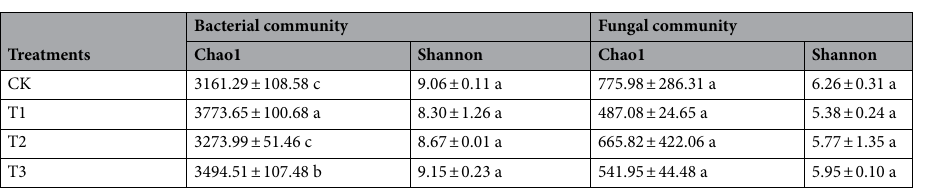
Table 2. Alpha diversity indexes of bacterial and fungal community in different treatments. Different letters indicate significant differences at p < 0.05 (according to Duncan’s multiple range test).